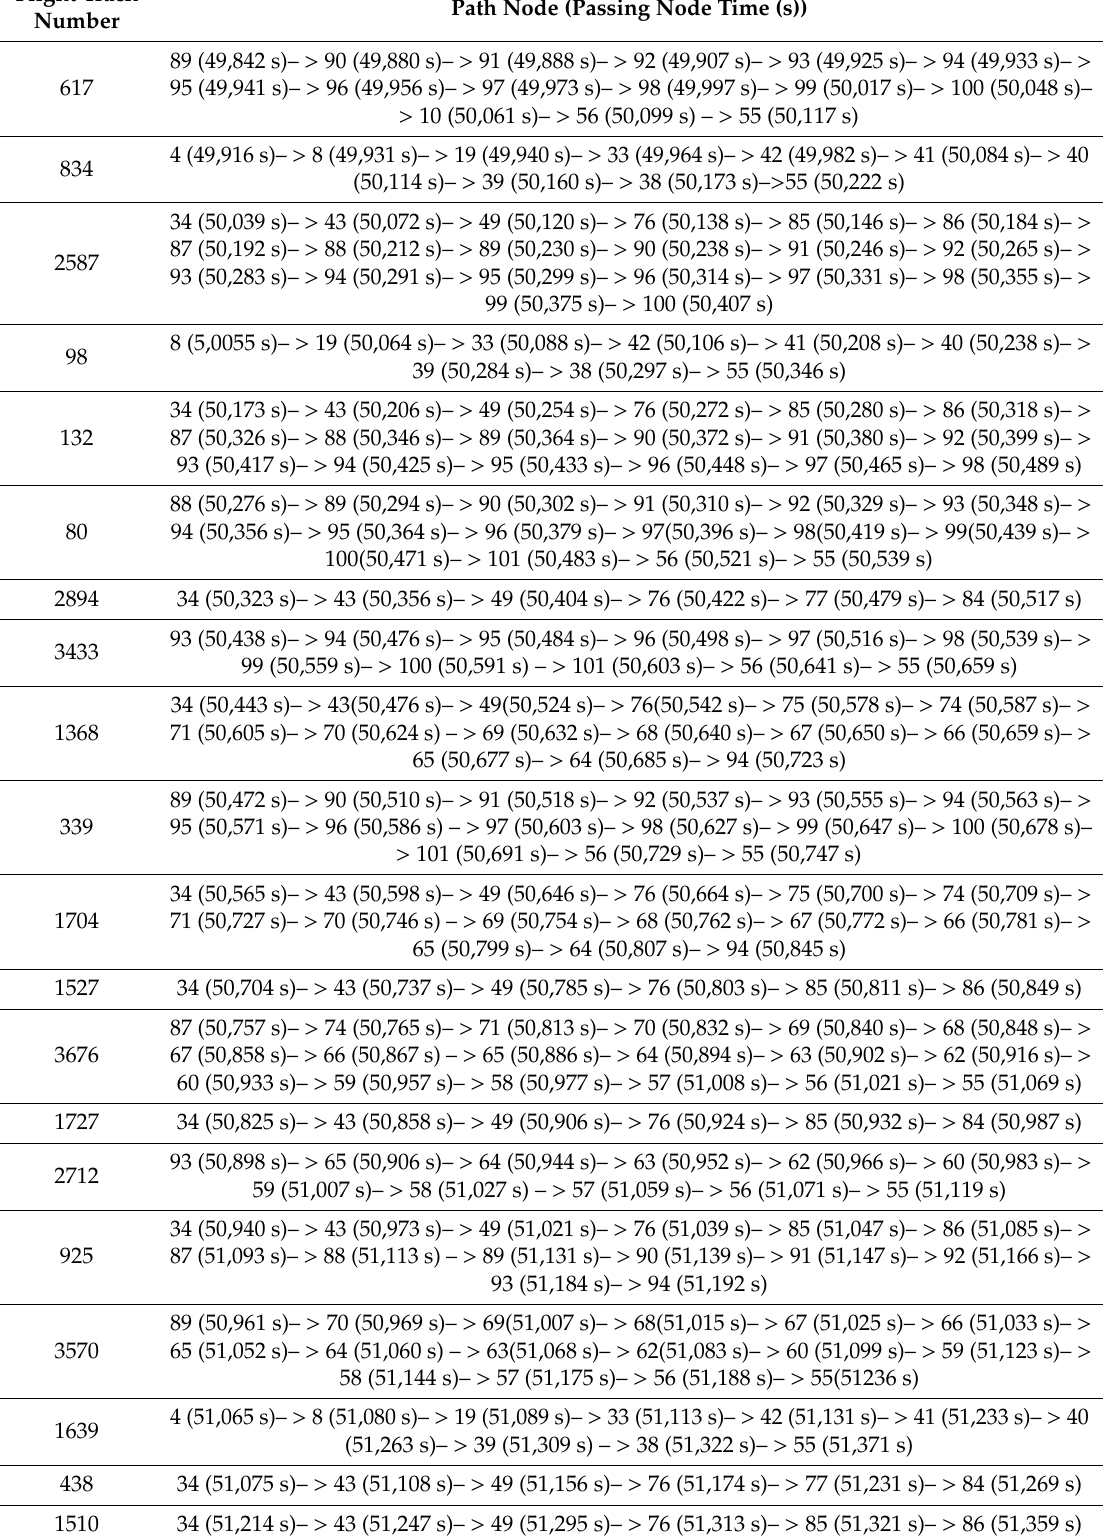
Table A1. The taxiing path of each aircraft, and the moment when the aircraft passes through each node. Flight